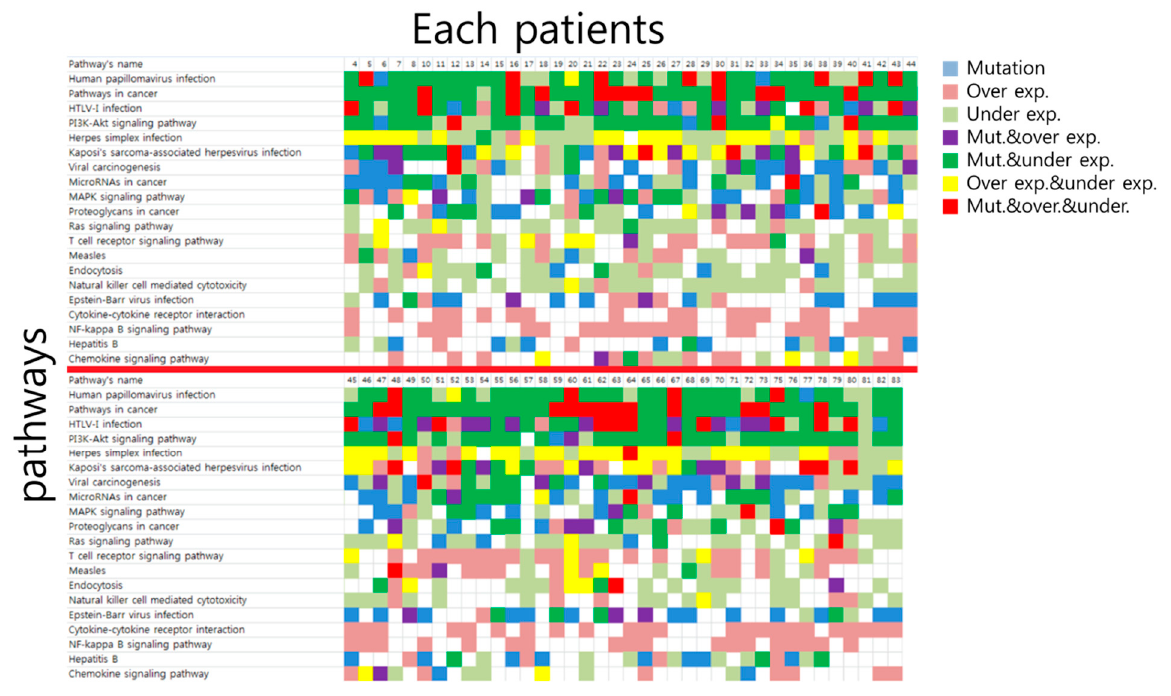
Figure 3. Oncoplot for top 20 pathway analyses in all patients.